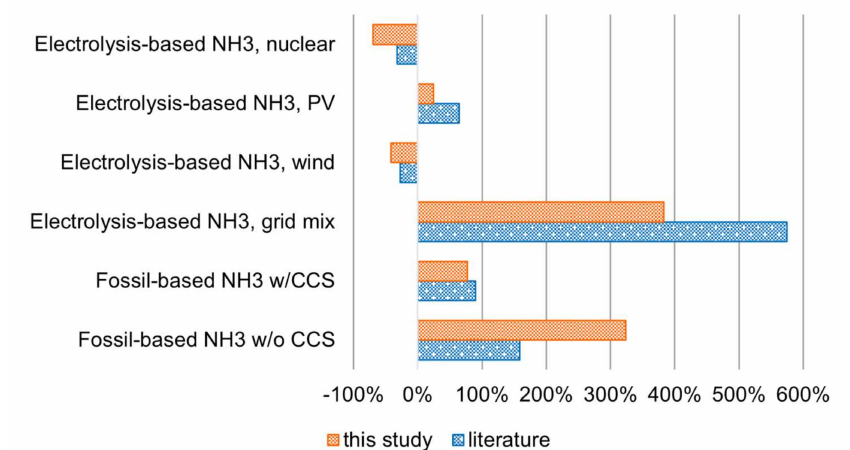
Figure 7. Global warming potential relative to benchmark: natural gas combustion in a gas turbine for [16], and electricity production from a conventional natural gas plant for this